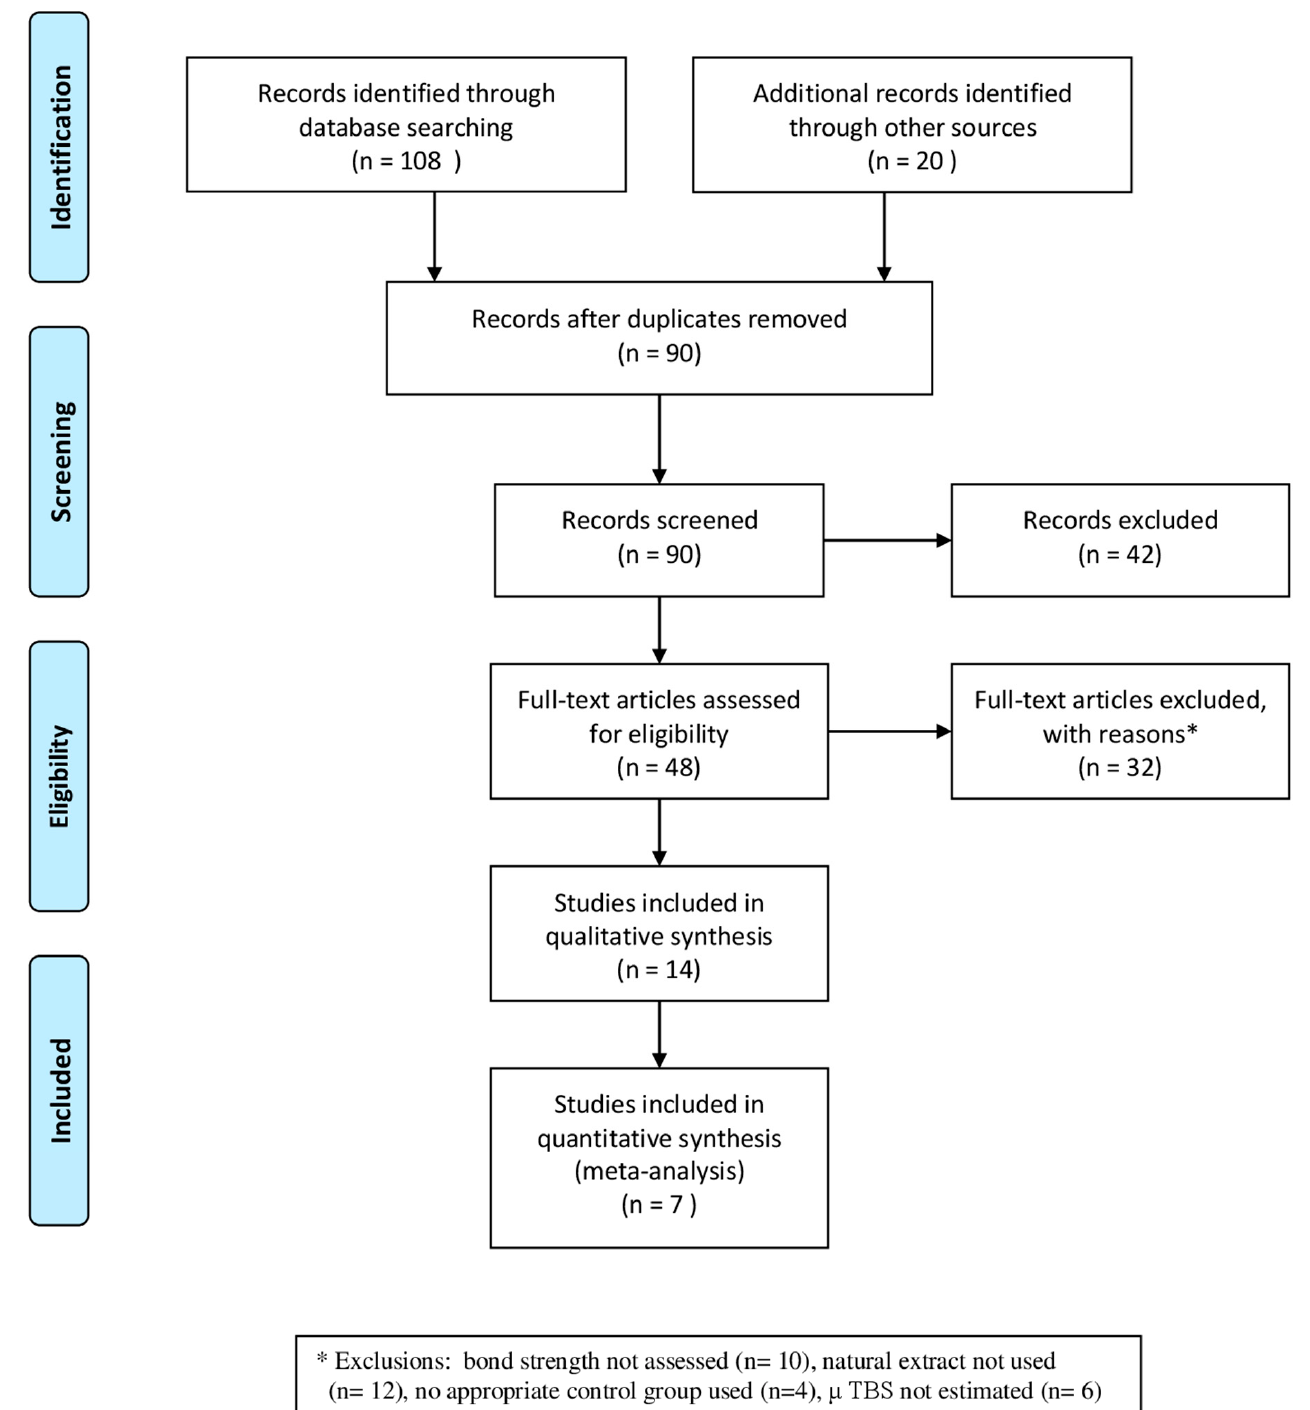
Figure 1. Flow diagram of study selection according to PRISMA statement.